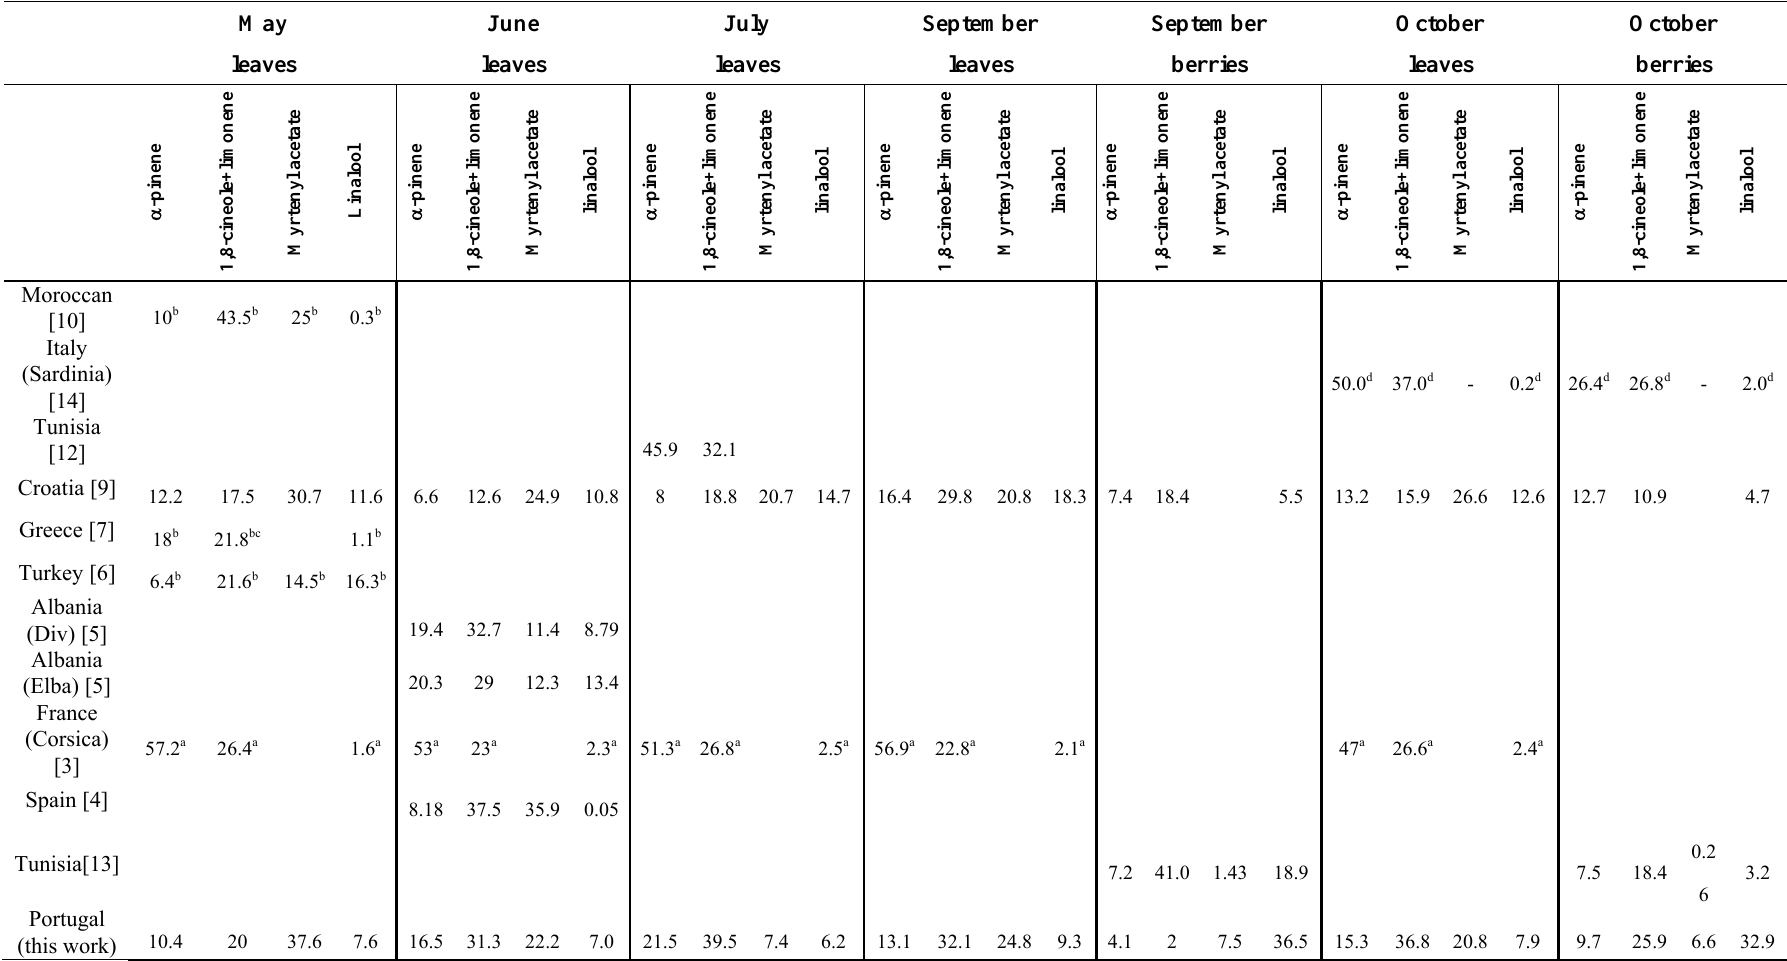
Table 5. Comparison of essential oil composition of Myrtle from different